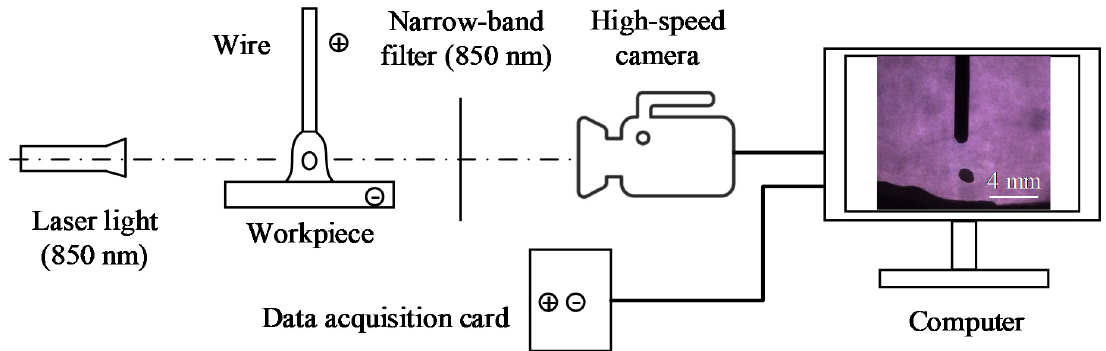
Figure 1. Schematic diagram of the welding and high-speed camera system.